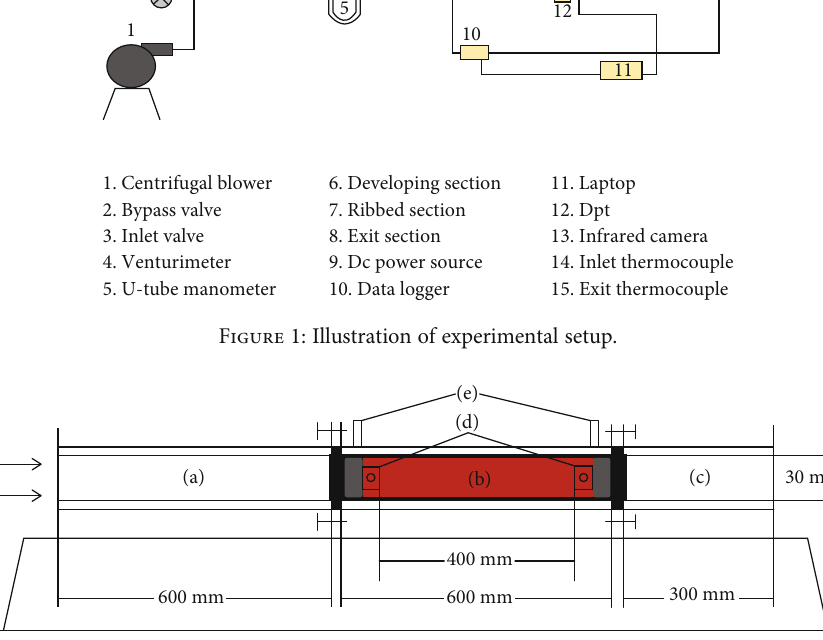
Figure 2: Schematic of (a) developing section, (b) ribbed section, and (c) exit